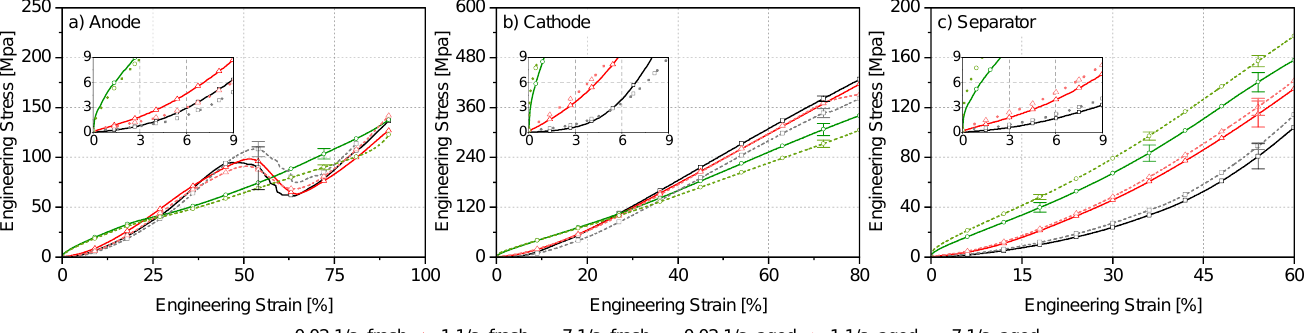
Figure 5. Comparison of compression test results of fresh and aged cell components considering different strain rates: ( a ) anode, ( b ) cathode, and ( c )